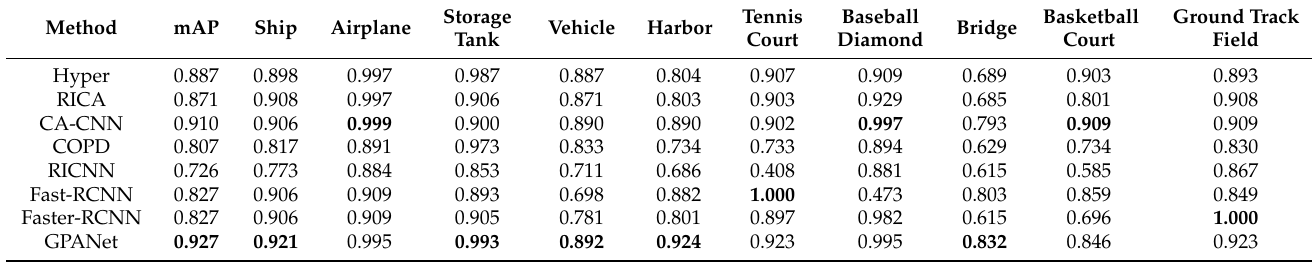
Table 6. The performance of mainstream models.